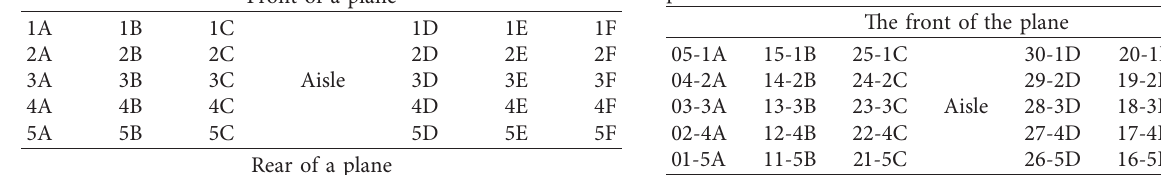
Table 2: Match between chairs in the waiting room and seats in the